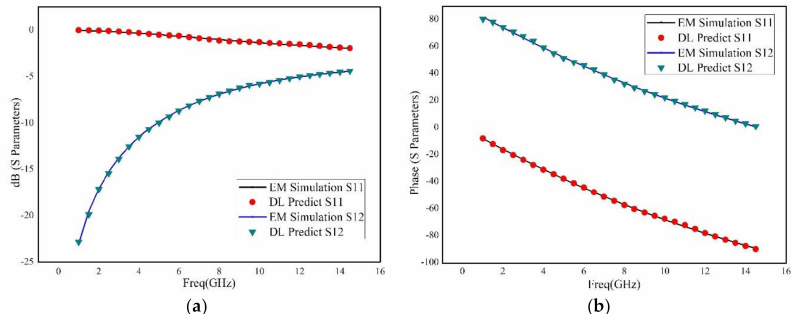
Figure 9. For interdigital capacitor modeling, results of the deep learning versus the EM simulation for non-uniformly sampling when a 5-hidden-layer neural network with 20 neurons on each layer is used. ( a ) dB of S Parameters. ( b ) Phase of S Parameters.